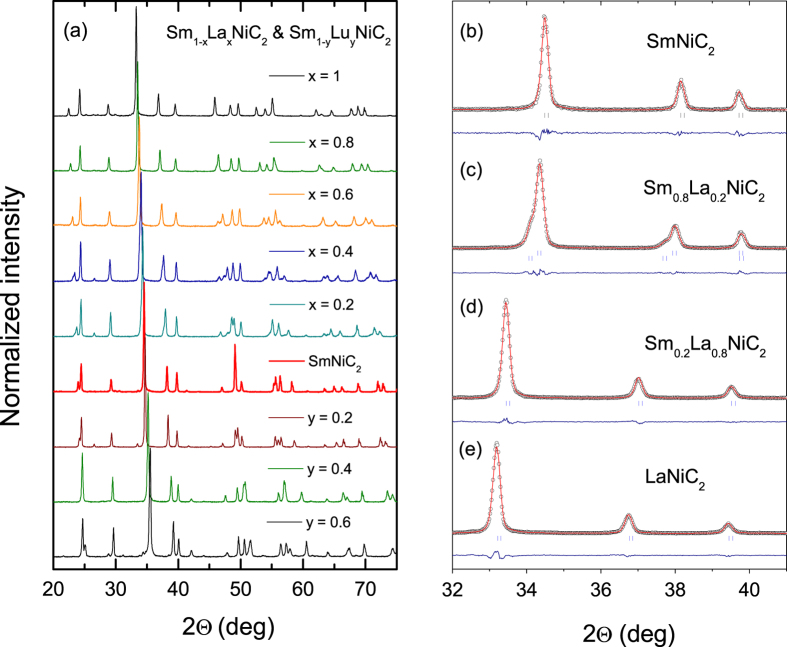
Powder x-ray diffraction (XRD) patterns.(a) XRD for the series Sm1−xLaxNiC2 for x = 0, 0.2, 0.4, 0.6, 0.8, 1 and Sm1−yLuyNiC2 for y = 0.2, 0.4, 0.6. (b) Enlarged image of the main peak (111) showing a shift from right to left for SmNiC2 and LaNiC2 respectively. Open circles are experimental points, whereas calculated diffraction patterns is represented by a solid red line. Difference between experiment and a model is shown by a blue line. The vertical ticks correspond to the Bragg peaks for Sm1−xLaxNiC2.